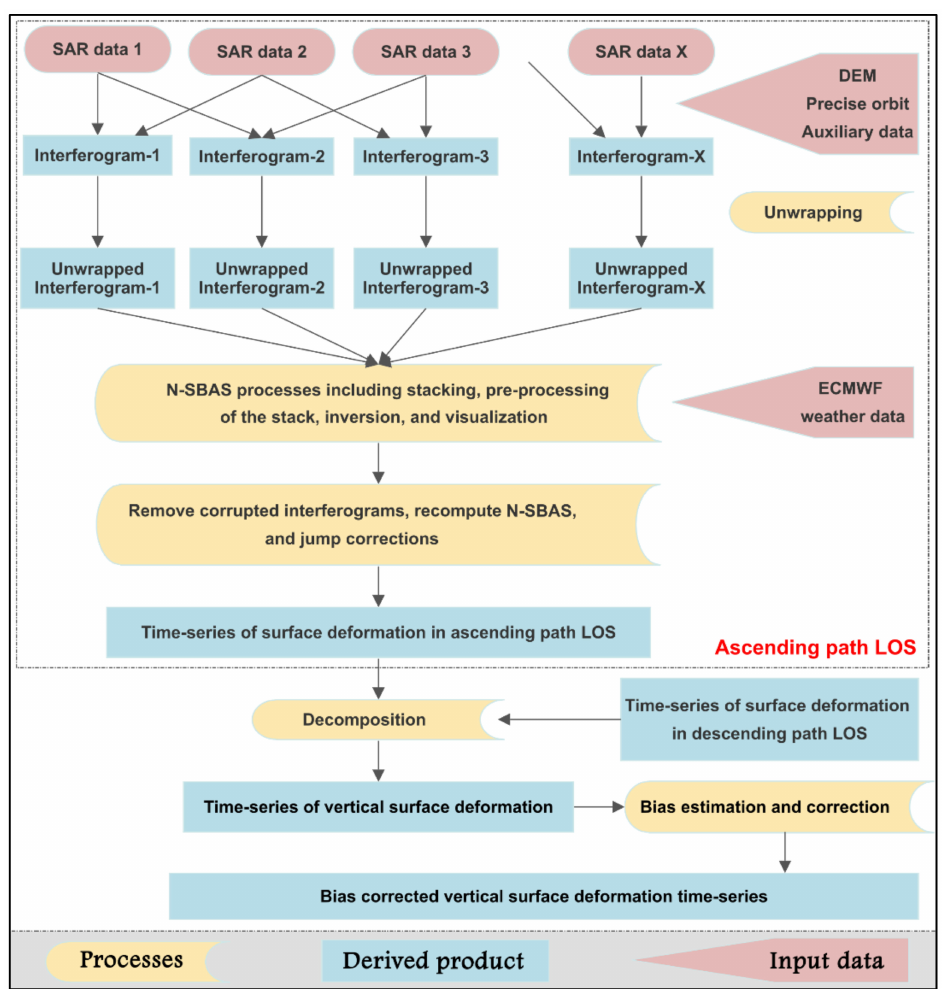
Figure 2. Flow-chart representing the workflow for the computation of the subsidence time-series using Sentinel-1 data. Attributes of each shape are given at the